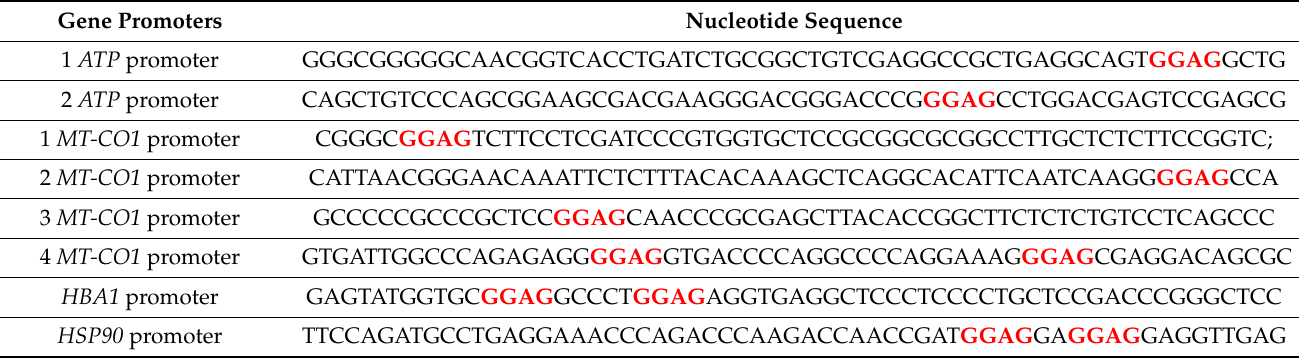
Figure 3. Interaction of AEDG peptide with H4 histone ( A ) and H1/6 histone ( B ) in accordance with the data obtained from the forcefield molecular modeling (Molecular Operating Environment, forcefield Amber12EHT). Histone molecules (Protein Data Bank) are depicted as α -helical domains and loops. Oxygen atoms are shown in red, nitrogen atoms in blue, carbon atoms in black, and hydrogen atoms in light gray. The peptide is highlighted in green. The dotted line shows hydrogen bonds. It should be noted that in an in vitro study, the KE peptide regulated the expression of this gene (Table 2), and that this correlates with the results of the molecular modeling. Similar studies have been conducted for the EW peptide (Table 4). Table 4. Human gene promoters in which the nucleotide sequence of dsDNA, to which the EW peptide binds, has been